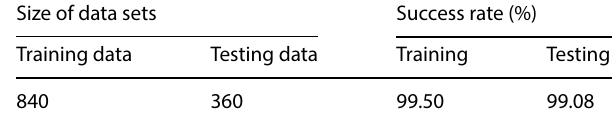
Table 7 Classification using ELM Size of data sets